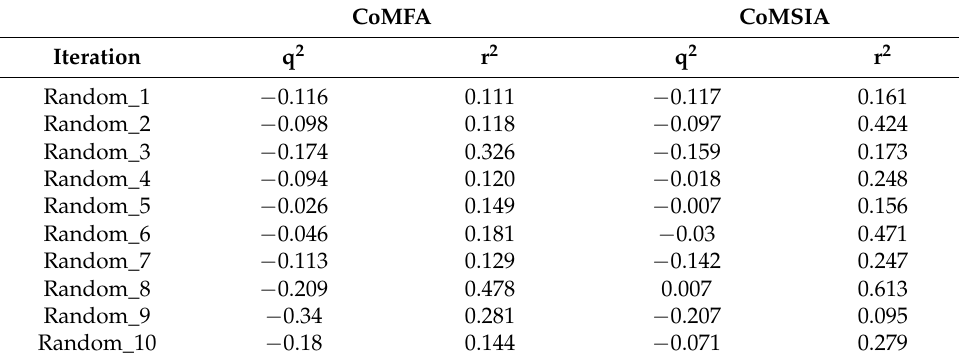
Table 3. The results of Y-randomization validation.